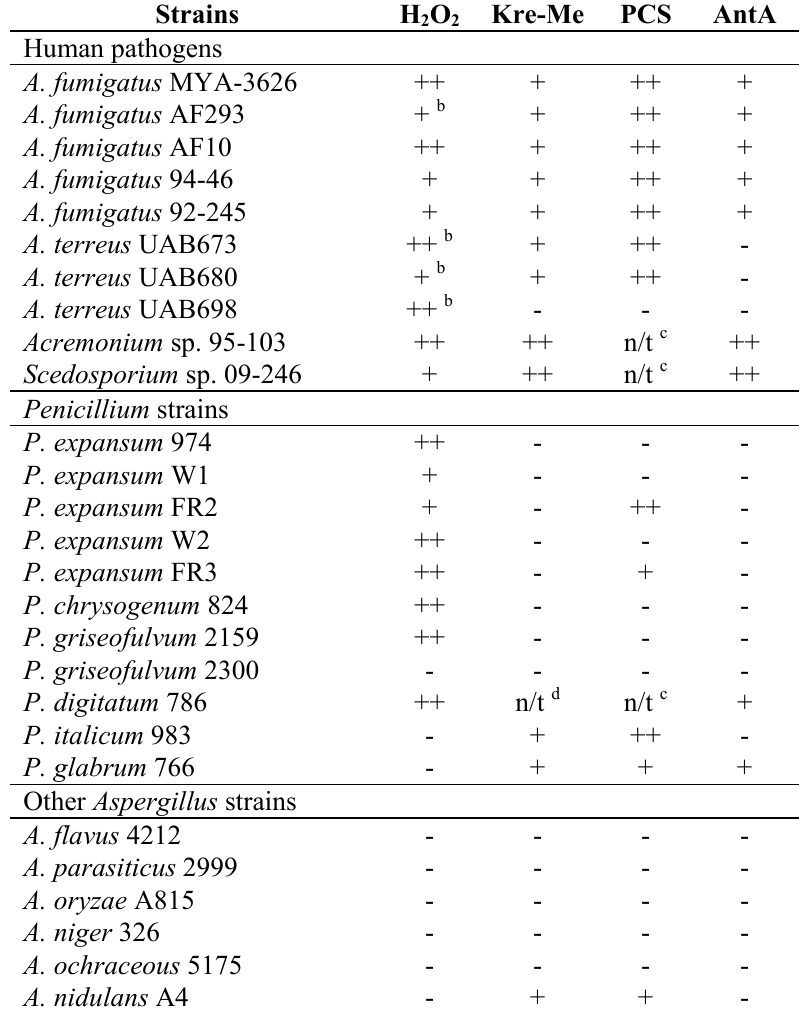
Table 2. Summary of responses of filamentous fungi to KA-mediated chemosensitization with H O or complex III inhibitors (agar plate bioassay) a 2 2